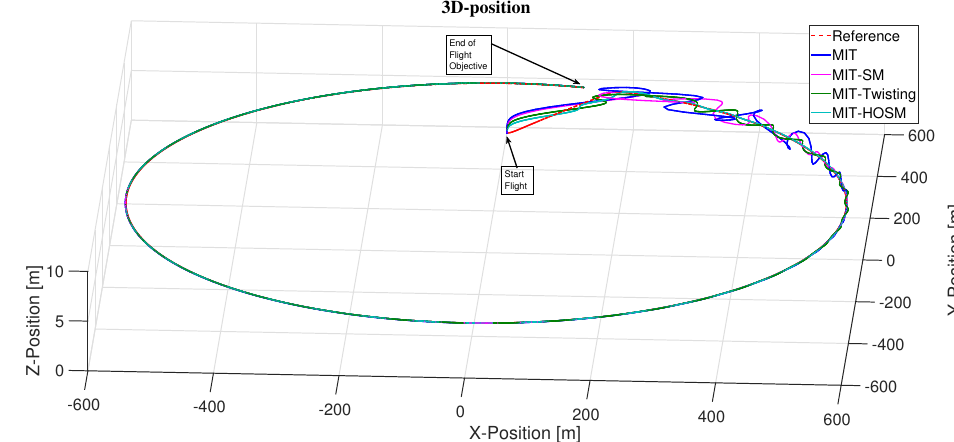
Figure 6. 3D Trajectory following responses (Top perspective).